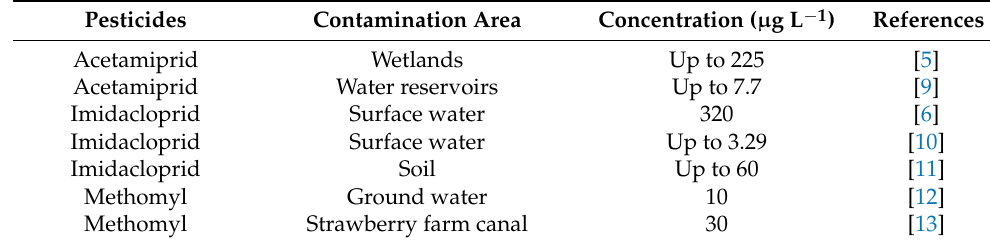
Table 1. Detection of acetamiprid, imidacloprid and methomyl pesticides in the environment.